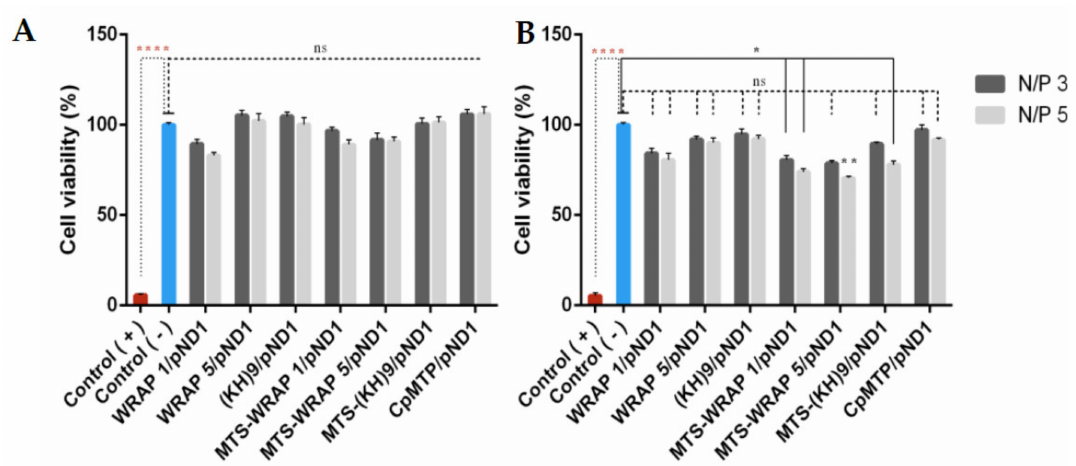
Figure 3. Cellular viability of HeLa cells after 24 h ( A ) and 48 h ( B ) of incubation with WRAP1/pND1, WRAP5/pND1, (KH)9/pND1, MTS-WRAP1/pND1, MTS-WRAP5/pND1, MTS-(KH)9/pND1 and CpMTP/pND1 nanoparticles conceived at N/P ratios of 3 and 5. Non-transfected cells were used as negative control and ethanol-treated cells were used as a positive control. A statistically significant difference was noticed between the positive and negative control (**** p < 0.0001). The MTS-WRAP1 N/P ratios of 3 and 5, MTS-(KH)9 N/P ratio of 5 (* p < 0.05) and MTS-WRAP5 N/P ratio of 5 (** p < 0.01) systems demonstrated a statistical difference in relation to the negative control at 48 h. The viability of cells transfected with the remaining systems did not show statistically significant differences compared to non-transfected cells